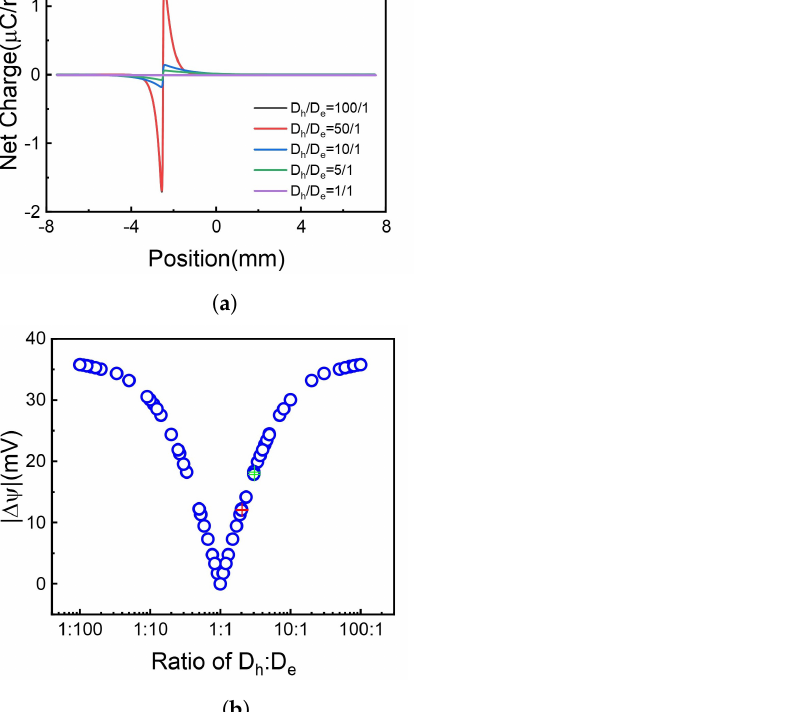
Figure 6. The net charge distribution and absolute voltage difference at different D e / D h ratios. ( a ) Net charge distribution. ( b ) Voltage difference, red and green cross stands for same ratio but different absolute value. Different colors indicate different values but the same